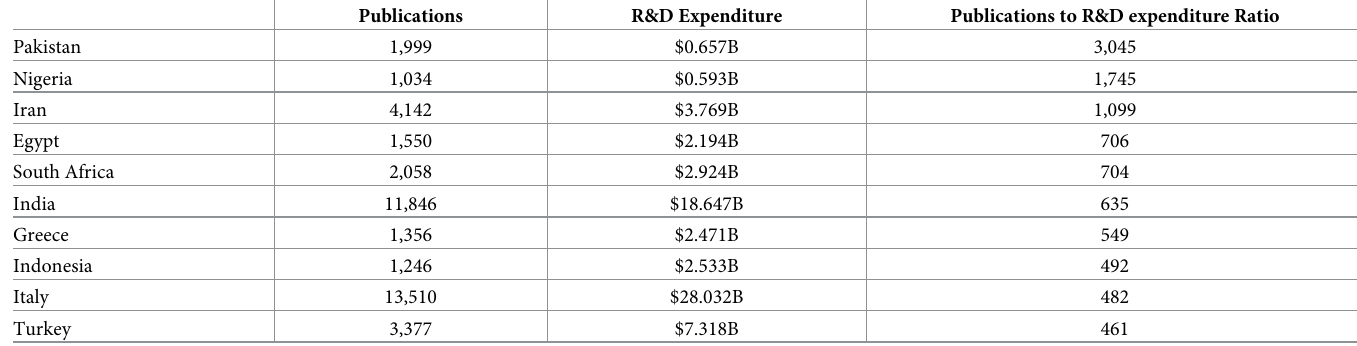
Table 1. The top ten countries in COVID-19 publications to R&D expenditure ratio among settings with at least 1000 COVID-19